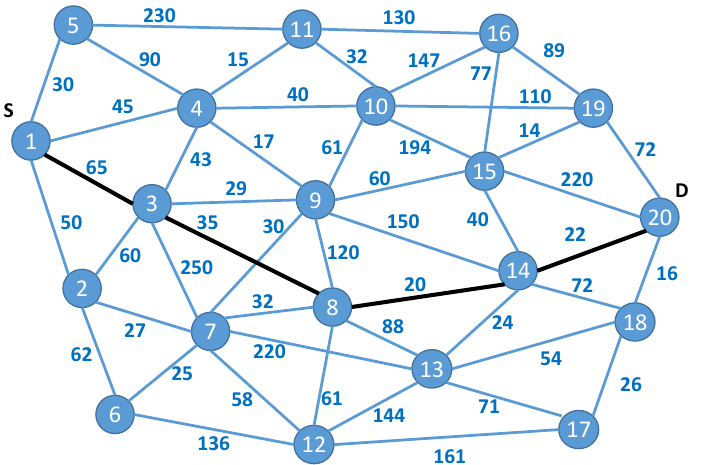
Figure 9. The graph used in the second scenario with bandwidth requirements near the corresponding edges (graph B).